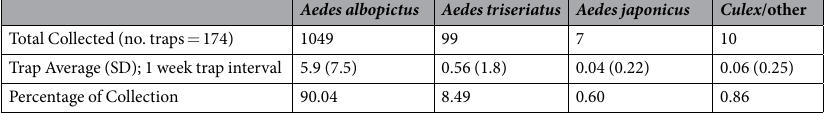
Table 1. Summary of urban mosquitoes collected in GATs in University Park, MD during August of